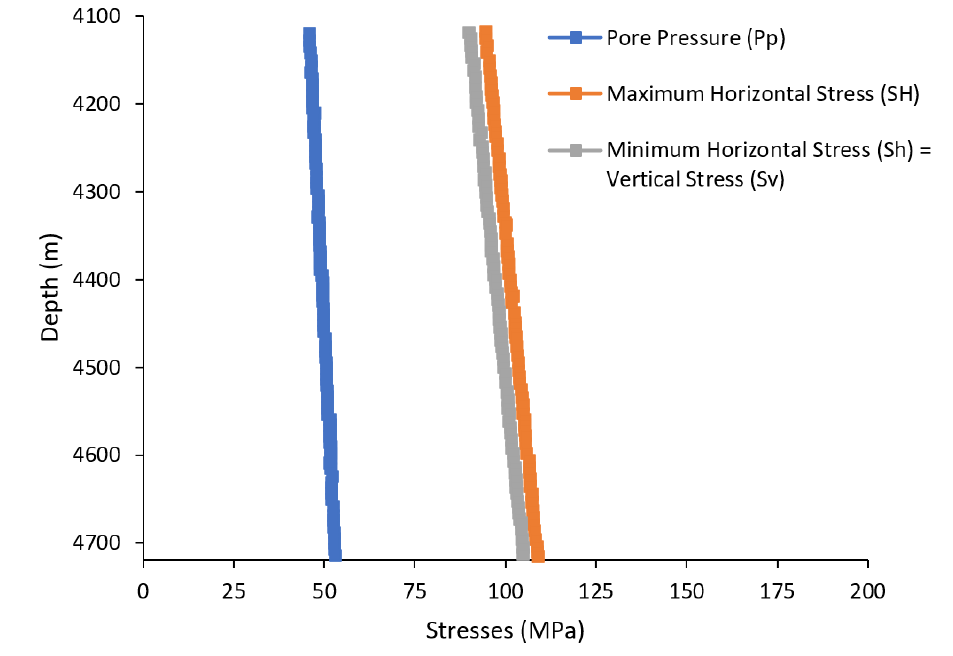
Figure 15. In-situ stresses and pore pressure results vs. the depth of wellbore-D in the Azar